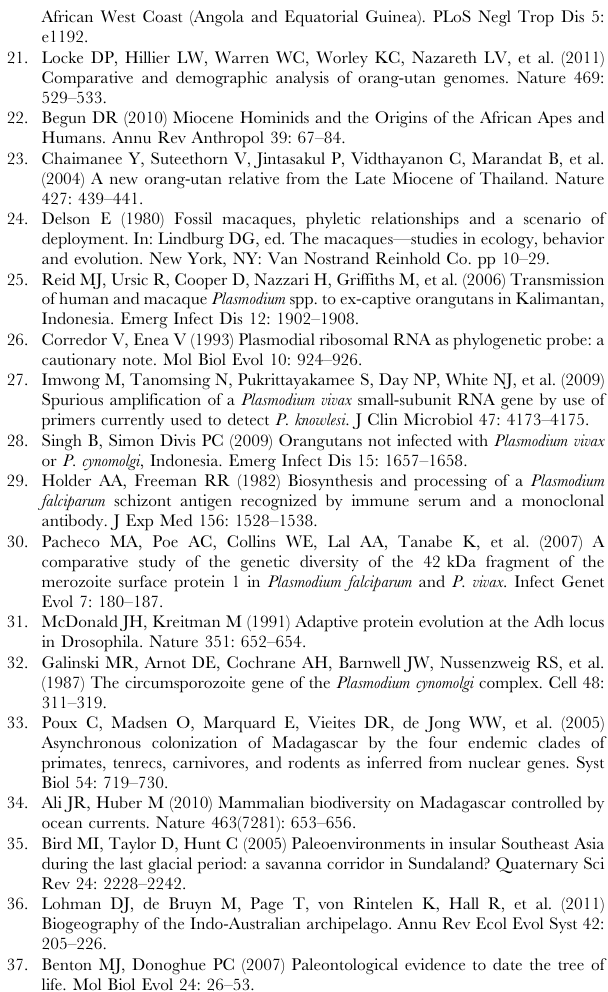
Figure S1 BEAST node numbers for the Plasmodium phylogeny as used in Table 5 and